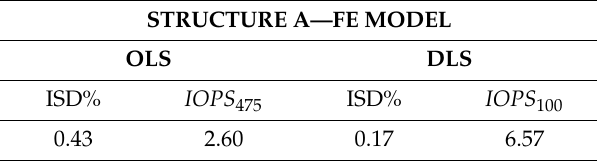
Table 13. Maximum Interstory Drift (ISD) % and operativity indicators IOPS 475 and IOPS 100 for OLS and DLS,